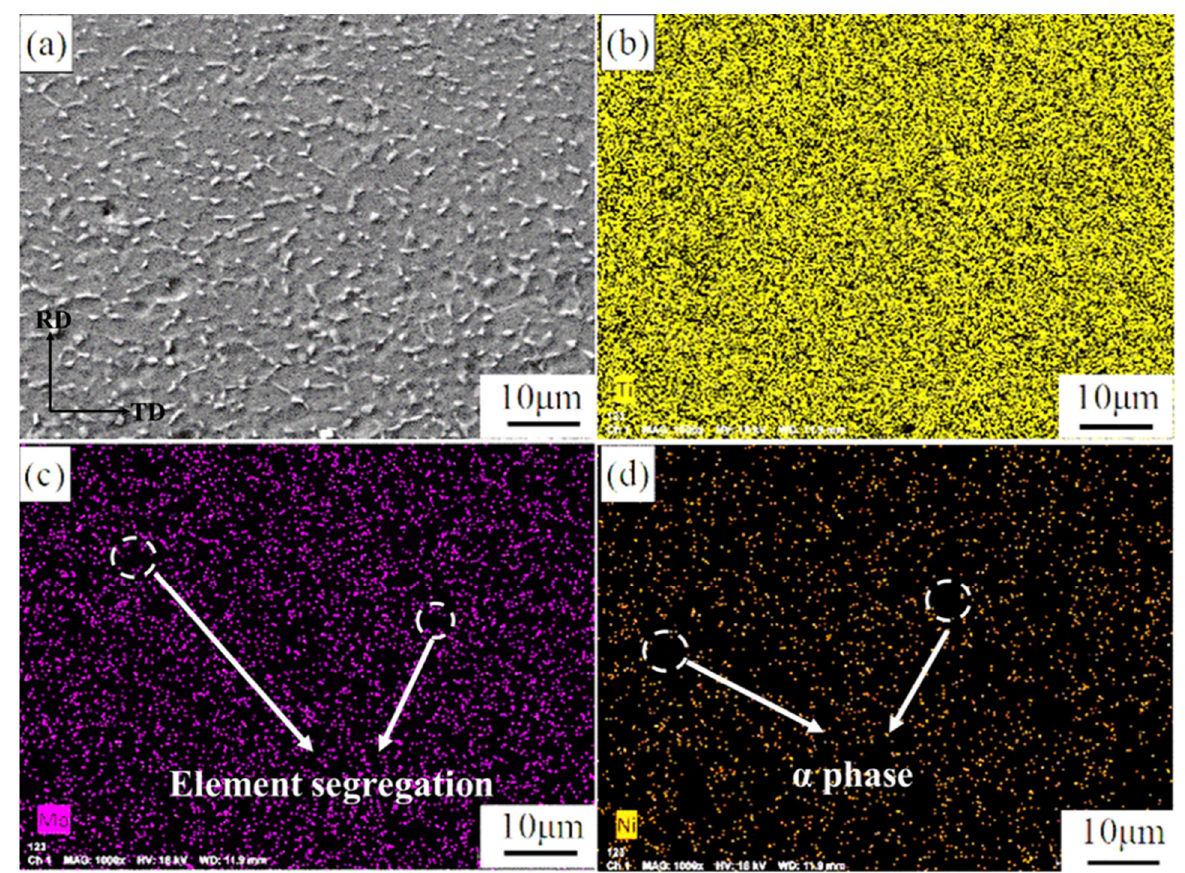
Figure 5. The surface scanning energy spectrum of TA10 alloy sheets annealed at 780 °C for 2 h ( a ) scanning surface, ( b ) Ti, ( c ) Mo, and ( d ) Ni.